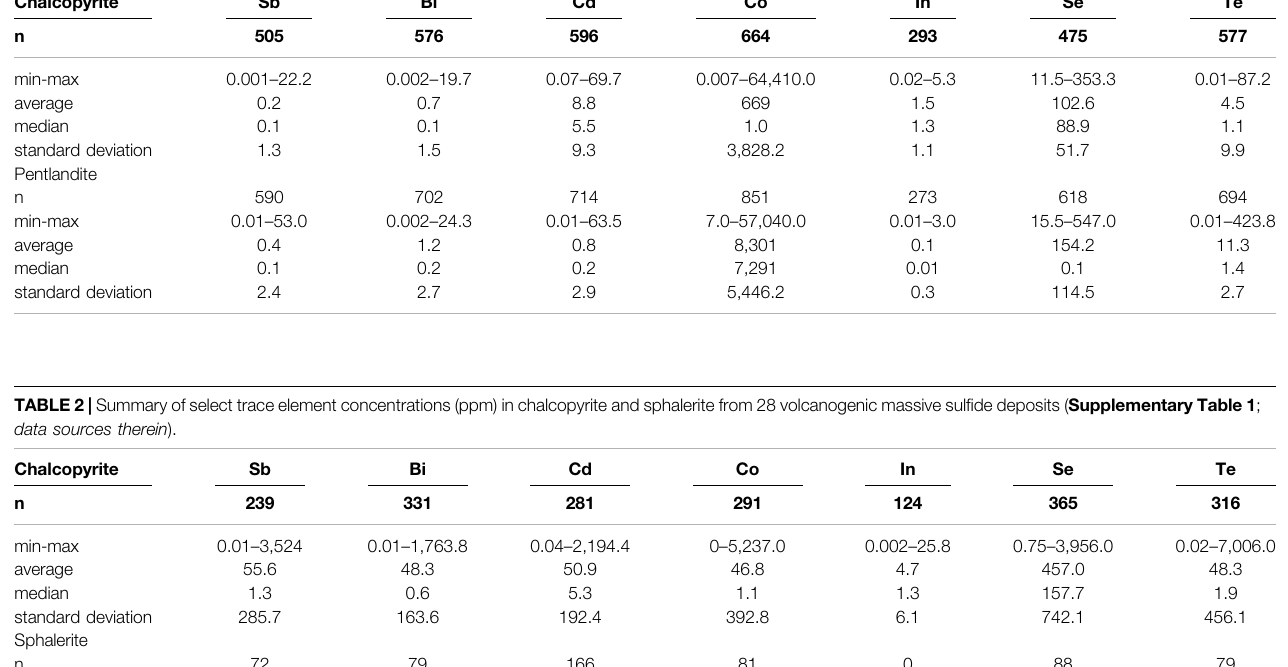
TABLE 1 | Summary of select trace element concentrations (ppm) in chalcopyrite and pentlandite from 22 magmatic sul fi de deposits ( Supplementary Table 1 ; data sources therein ). Chalcopyrite